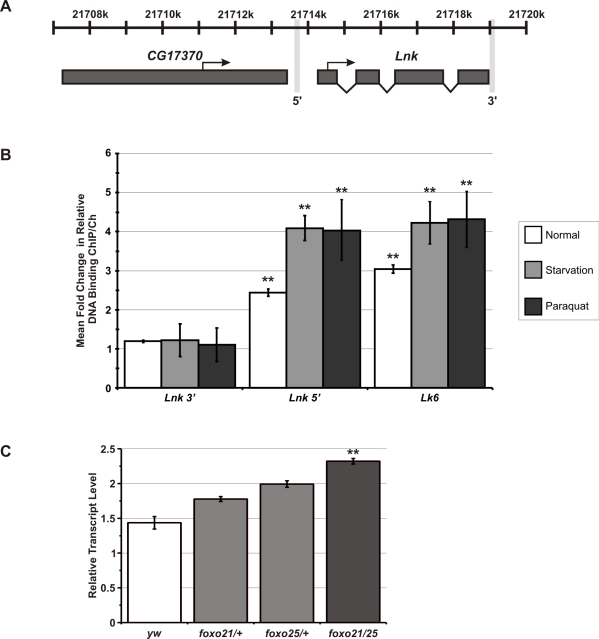
dFoxo binds to the promoter of Lnk and regulates Lnk expression.(A) Schematic diagram showing in vivo binding region for dFoxo at the Lnk locus as detected by chromatin immunoprecipitation (ChIP). Transcriptional start sites and the direction of transcription are indicated by arrows. The genomic region 3′ to the Lnk locus is also marked. (B) Quantitative PCR (qPCR) on the Lnk promoter, a 3′ region of the Lnk gene [as highlighted in (A)], the known dFoxo target gene, Lk6 and the U6 snRNA promoter (-87 to +61 from transcriptional start) to determine the proportion of DNA recovered after ChIP using anti-dFoxo antibody under normal, starvation and paraquat-treated conditions. Relative DNA binding was calculated as the proportion of chromatin recovered in the ChIP divided by that in the total chromatin preparation. Data are presented as mean fold-changes in relative DNA–binding compared to U6 ± SEM of three biological repeats (** p<0.05). (C) Lnk mRNA levels in dFoxo mutant flies measured by qRT–PCR and normalised to actin5C. Data are represented as mean normalised transcript level ± SEM (n = 3; **p<0.05).